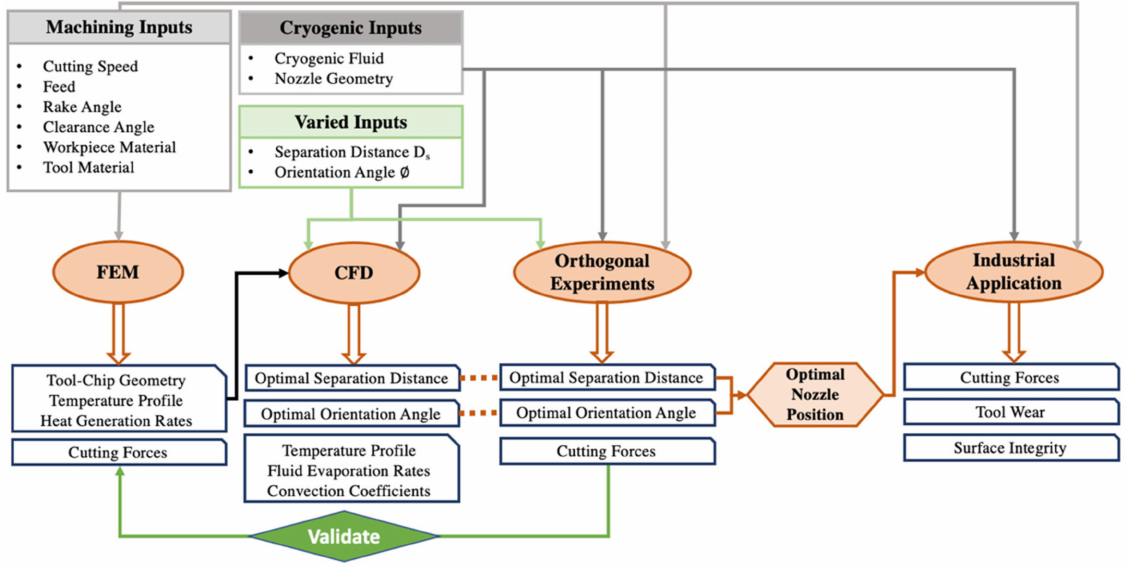
Figure 1. Methodology flowchart showing different parts of the